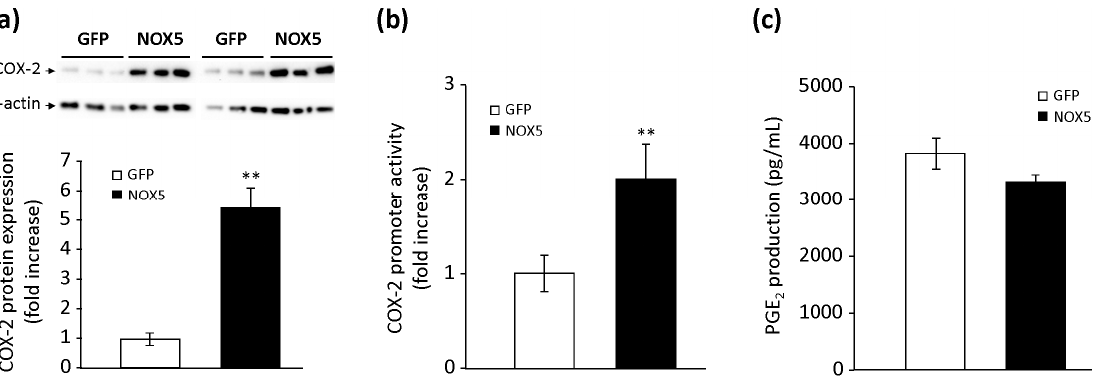
Figure 4. E ff ects of NOX5 pharmacological stimulation on PG biosynthesis. ( a ) Representative COX-2 and β -actin immunoblots of TeloHAEC infected for 24 h with GFP or NOX5- β adenovirus and stimulated with PMA + Io for 12 h, and quantification of COX-2 protein. n = 6. ** p < 0.01 vs. GFP. ( b ) COX-2 promoter transcriptional activity of TeloHAEC infected for 24 h with GFP or NOX5- β and stimulated with PMA + Io. n = 6. ** p < 0.01 vs. GFP. ( c ) PGE 2 levels present in cell supernatant after 24 h of infection and stimulation with PMA + Io. n = 6.